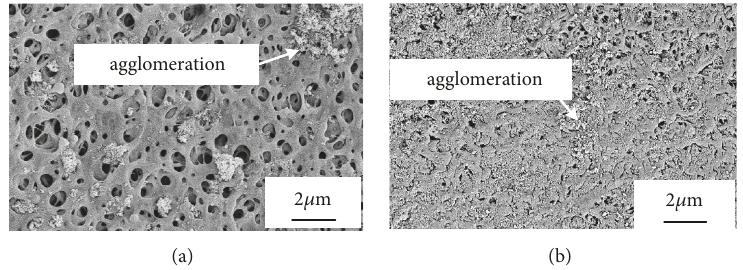
Figure 1: SEM image of the surface of the treated layer (a) before and (b) after applying the compression load.